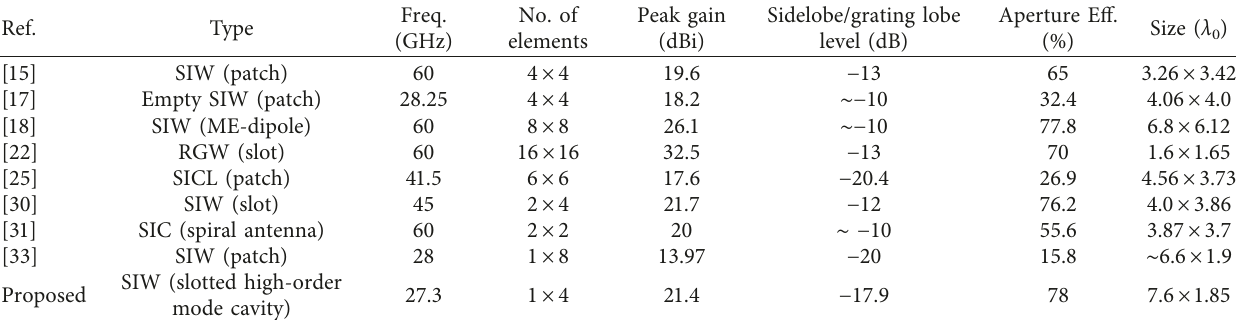
Table 3: Performance comparison with other reported planar MMW antenna arrays.